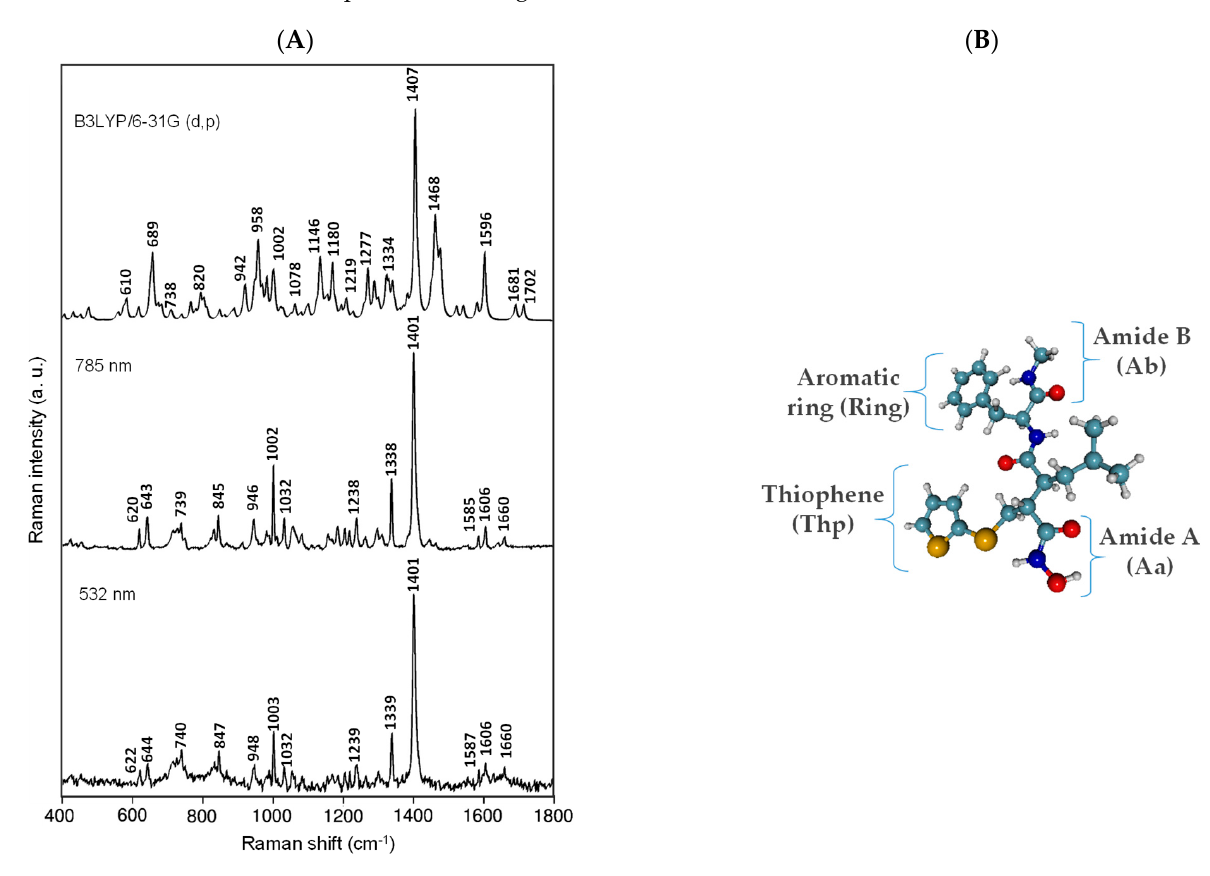
Figure 1. Experimental Raman spectra of BB-94 recorded at different wavelengths and theoretical Raman spectra at B3LYP/6-31G(d,p) ( A ); optimized structure of BB-94 at B3LYP/6-31G(d,p) level of theory, indicating some functional groups discussed in this work ( B ).